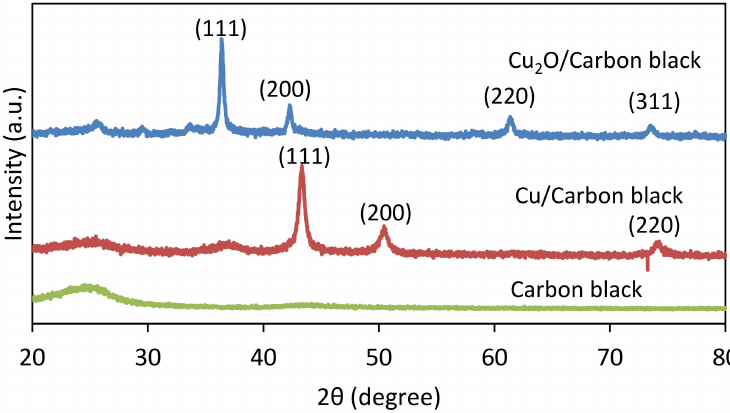
Figure 1. XRD patterns of Cu and Cu 2 O/carbon black and carbon black.